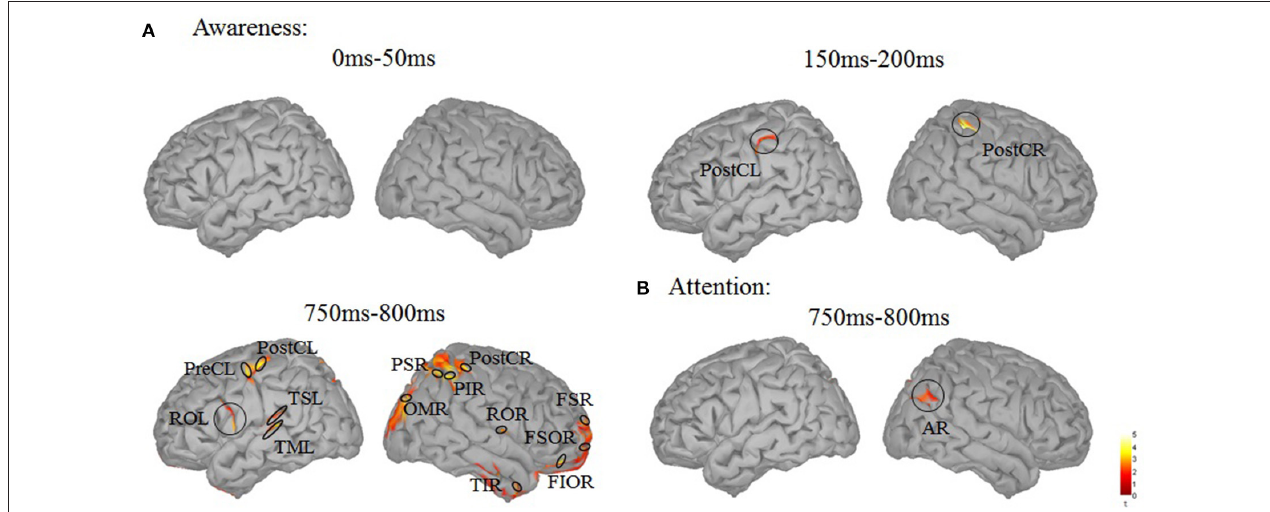
FIGURE 4 | Source localization of the main effects. (A) Contrast between the aware and unaware conditions, in the 0–50, 150–200, and 750–800ms time-windows. Significant sources were observed in the bilateral central cortex (150–200ms) and in widely distributed areas [including bilateral postcentral gyrus (PostC), left precentral gyrus (preCL), bilateral Rolandic operculum (OR), left superior temporal lobe (TSL), left middle temporal lobe (TML), right orbital inferior frontal lobe (FIOR), right superior frontal lobe (FSR), right orbital superior frontal lobe (FSOR), right middle occipital lobe (OMR), right inferior parietal lobe (PIR), right superior parietal lobe (PSR) and right inferior temporal cortex (TIR)]. (B) Contrast between attended and unattended trials, in the 750–800ms time-window. One significant source was observed in the right angular gyrus (AR).